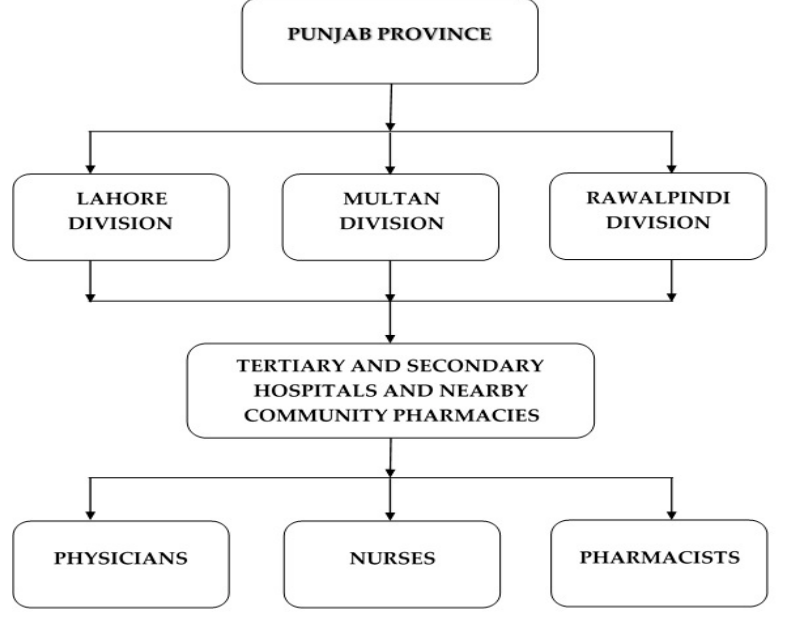
Figure 1. Study Population.